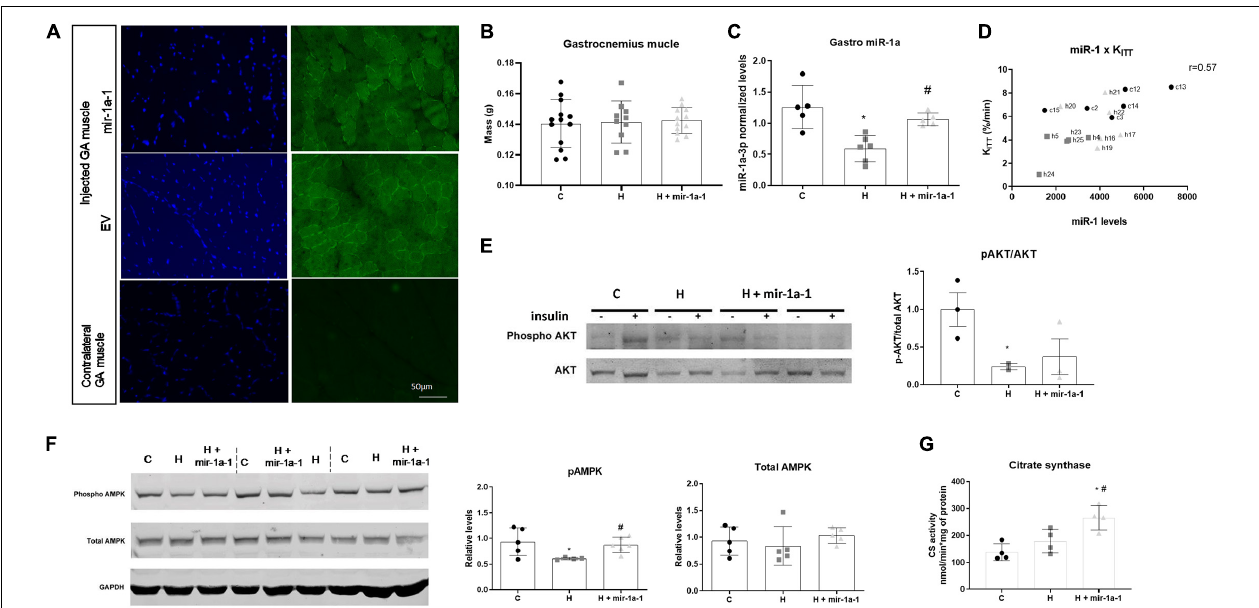
FIGURE 2 | Increased miR-1 levels in gastrocnemius muscle of obese mice restores pAMPK levels. (A) Representative fluorescence images of GFP-positive fibers in gastrocnemius (GA) sections after 28 days of transfection of the empty vector (EV) or miR-1 precursor (mir-1a-1) and contralateral non-injected GA. Blue = DAPI for nuclei identification; Green = GFP-positive fibers; (B) GA mass ( n = 10–13); (C) miR-1 levels in GA muscle of control (C), obese (H) and miR-1 precursor-treated obese (H + mir-1a-1) mice ( n = 5); (D) correlation analysis between miR-1 expression and K ITT values ( n = 5); (E) Representative blots of phospho and total AKT levels after stimulation of soleus muscle with insulin. Phospho and total AKT were normalized by ponceau-stained total protein content and phospho/total AKT ratio was calculated ( n = 2–3); (F) Representative phospho and total AMPK and GAPDH levels. Relative phospho and total AMPK content was calculated after normalization with GAPDH ( n = 5); (G) Citrate synthase activity in gastrocnemius muscle ( n = 4). *# p < 0.05 as indicated by one-way ANOVA followed by Tukey’s post-test. (*) vs. control (C), (#) vs. obese